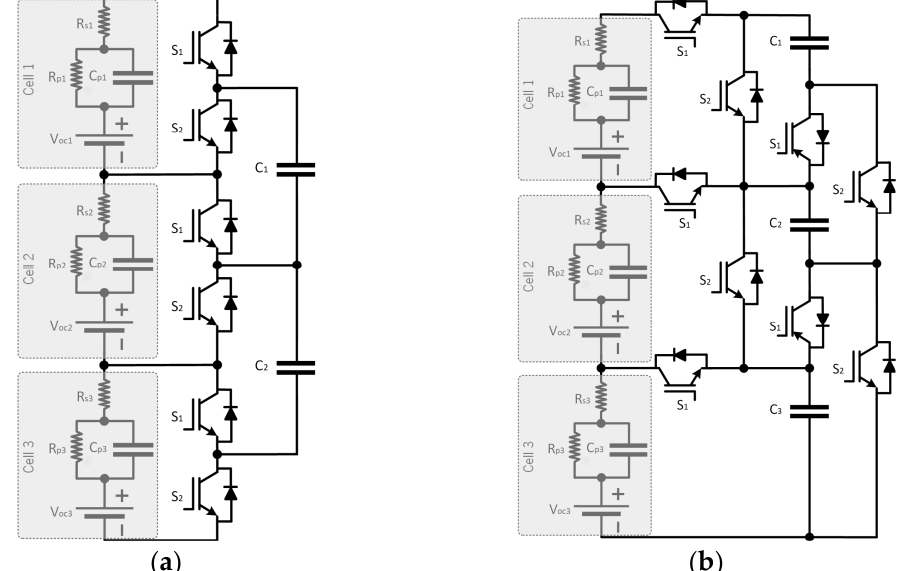
Figure 2. Switched-capacitor converter: ( a ) conventional version; ( b ) improved version proposed in [29].